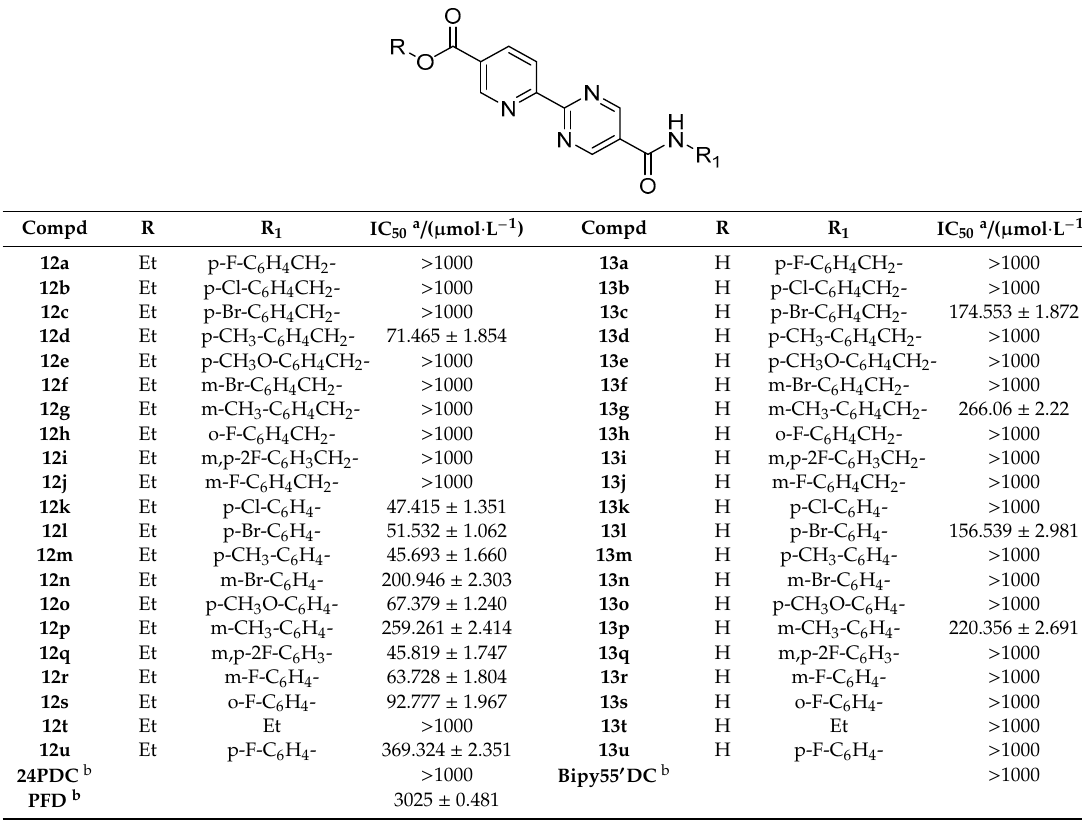
Table 1. The IC 50 values of the compounds 12a – 12t and 13a – 13t by MTT assay.